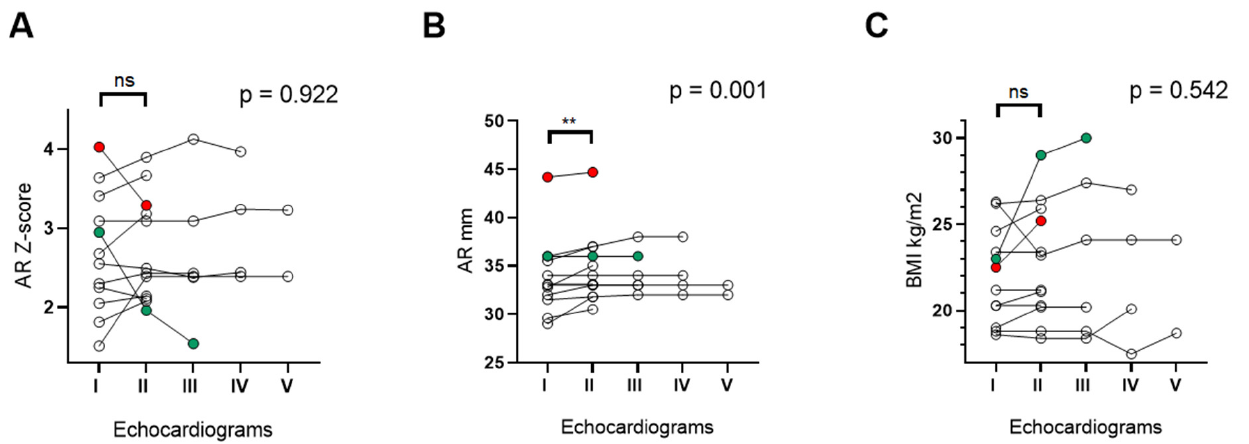
Figure 1. Longitudinal course of Z-score (panel A ), absolute values of AR diameter (panel B ) and changes in BMI (panel C ) over the time of follow-up. The two-way ANOVA test was used to evaluate changes in AR and BMI over time (reported as p values). Wilcoxon matched pair signed-rank test was used to compare the first and second echocardiograms. Significant p values are shown as ** ( p < 0.01). AR: aortic root, ns: not significant, BMI: body mass